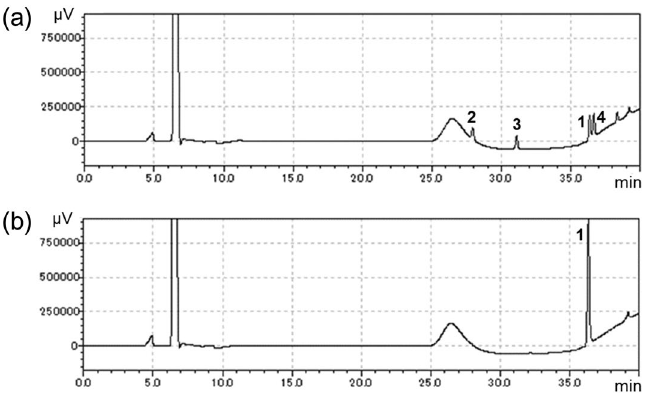
Figure 2. HPLC analysis of the reaction products formed by incubation of strain TUS-SO1 with 2-PAP. Microbial cells after cultivation on solid basal medium supplemented with nitrohumic acid were suspended in liquid basal medium supplemented with 0.1 g/L yeast extract and 1% (v/v) Tween 80. The cell suspension was incubated with 1 mM 2-PAP for 72 h. Intact cells ( a ) or autoclaved cells ( b ) of strain TUS-SO1 were incubated with 2-PAP. Peaks 1 (at 36.3 min), 2 (at 27.7 min), 3 (at 31.0 min), and 4 (at 36.6 min) correspond to 2-PAP, phenol, benzoate, and 2-PPE, respectively.